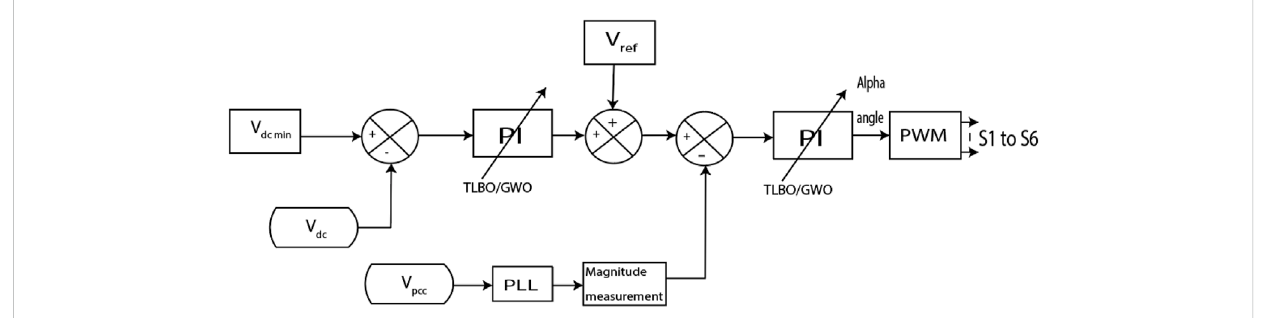
FIGURE 3 Detailed SSSC control system.